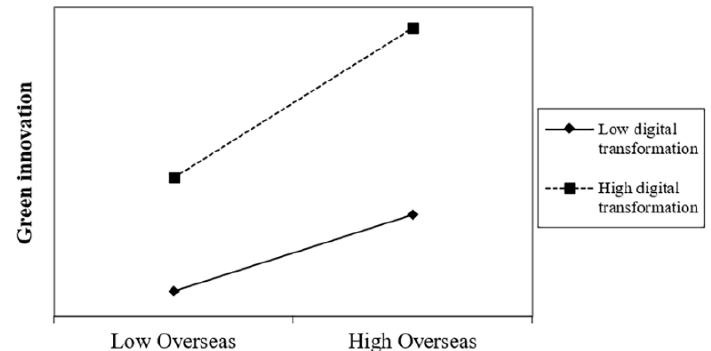
Figure 2. The moderating effect of digital transformation.